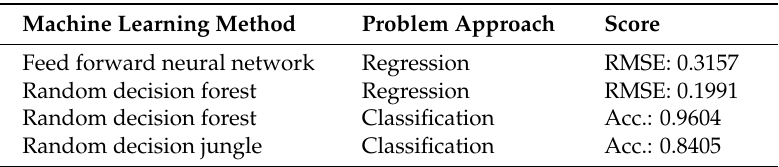
Table 5. Comparison of trained machine learning